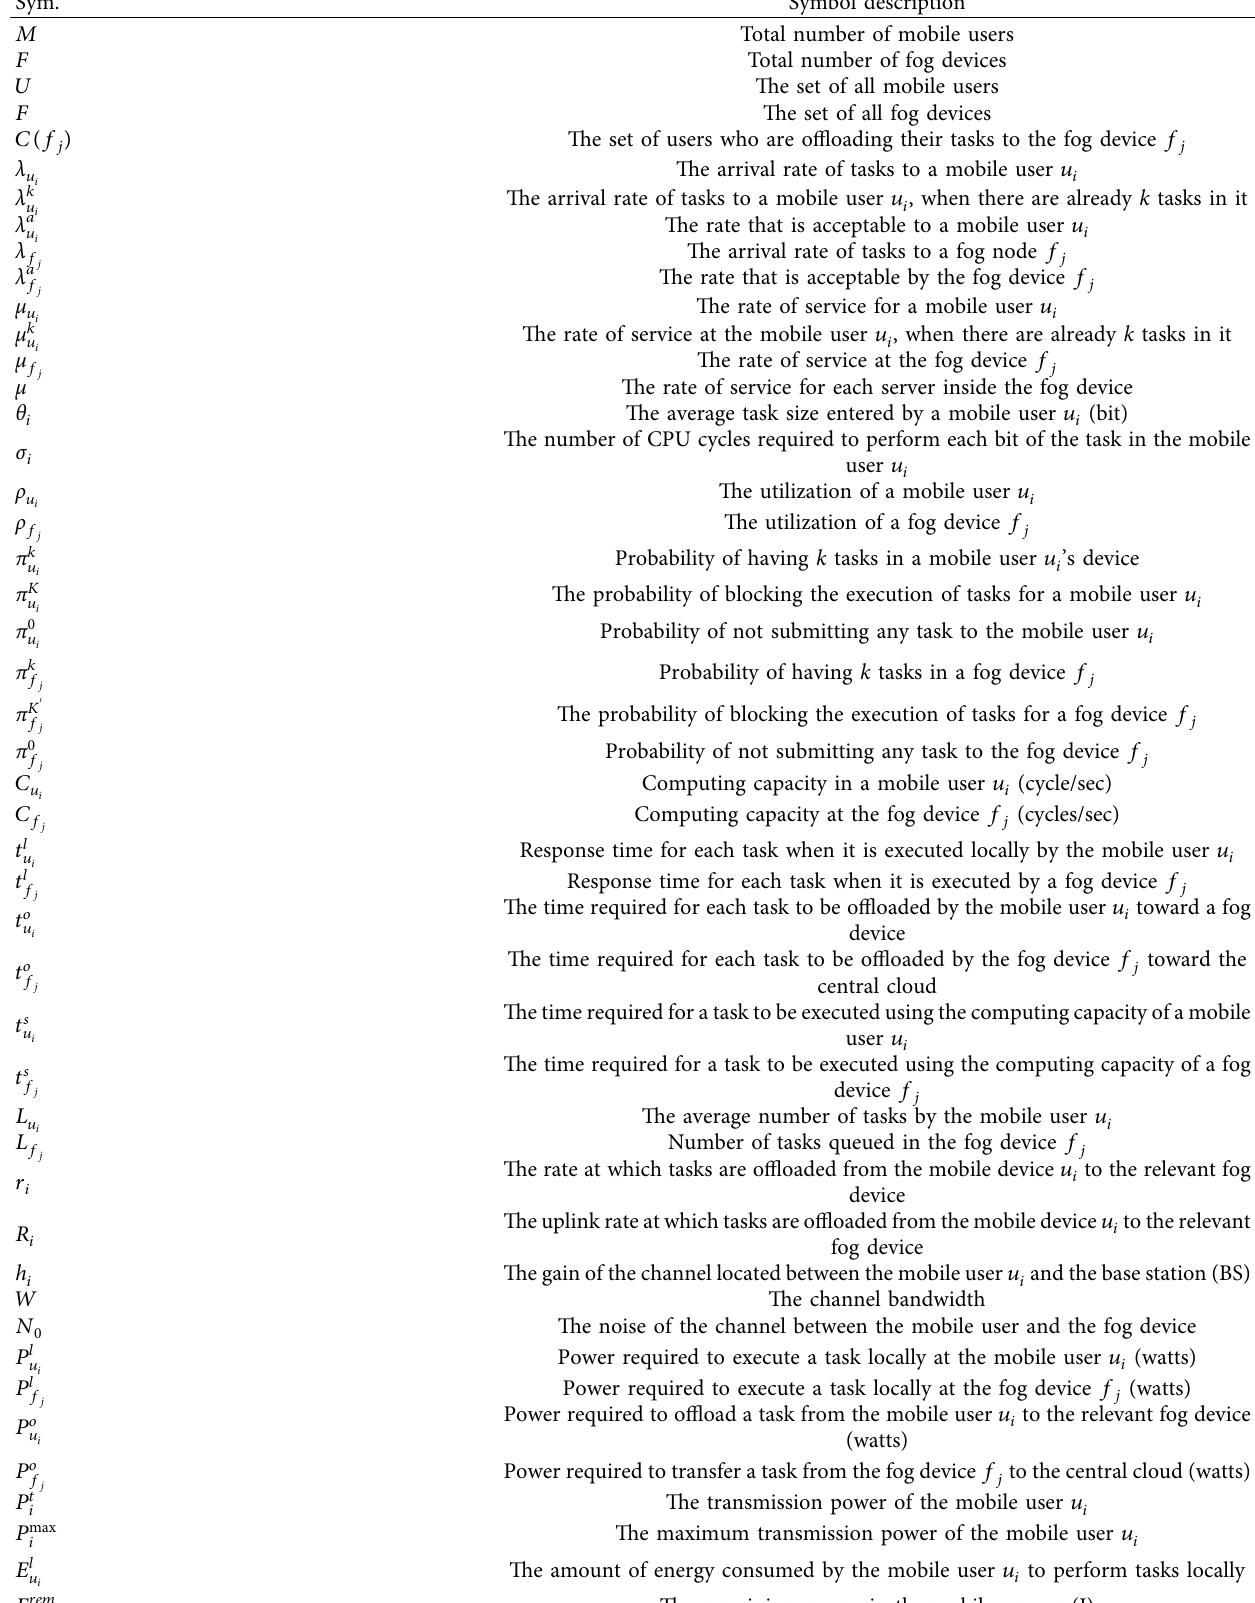
Table 1: Te notations used in this research.